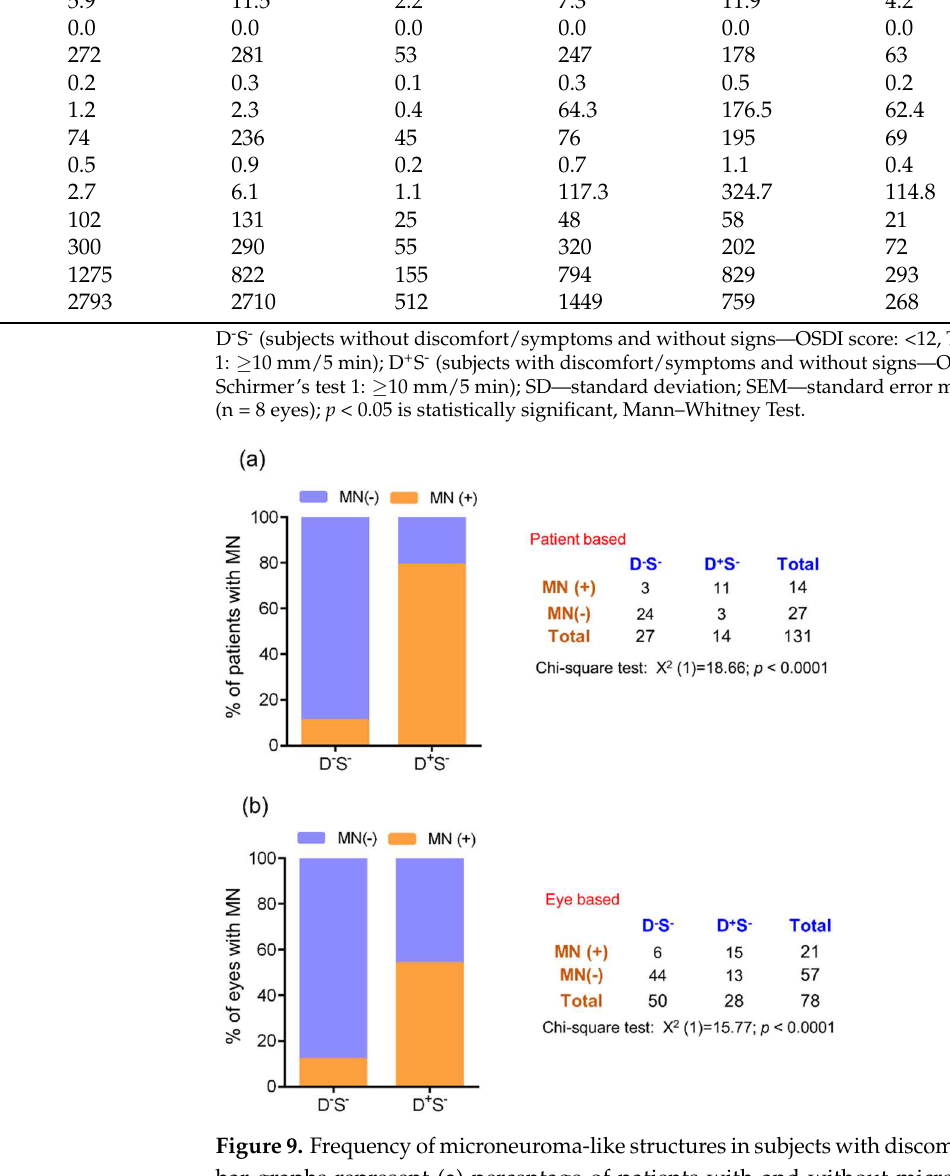
in laser scanning in vivo confocal microscopy images in the study subjects. D - S - indicates subjects without discomfort/symptoms and signs and D + S - indicates subjects with discomfort/symptoms but no signs. ( a ): D + S - , n = 58 eyes and D + S - , n = 28 eyes. *** p < 0.001, **** p < 0.0001, Mann–Whitney